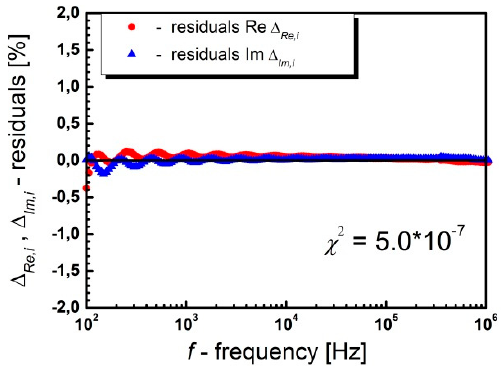
Figure 6. Residual spectrum (residuals) showing the frequency relationship of the relative difference between the experimental data and the data obtained as a result of the Kramers–Kroning (K-K) test at T = 230 °C for BLT4 ceramics.